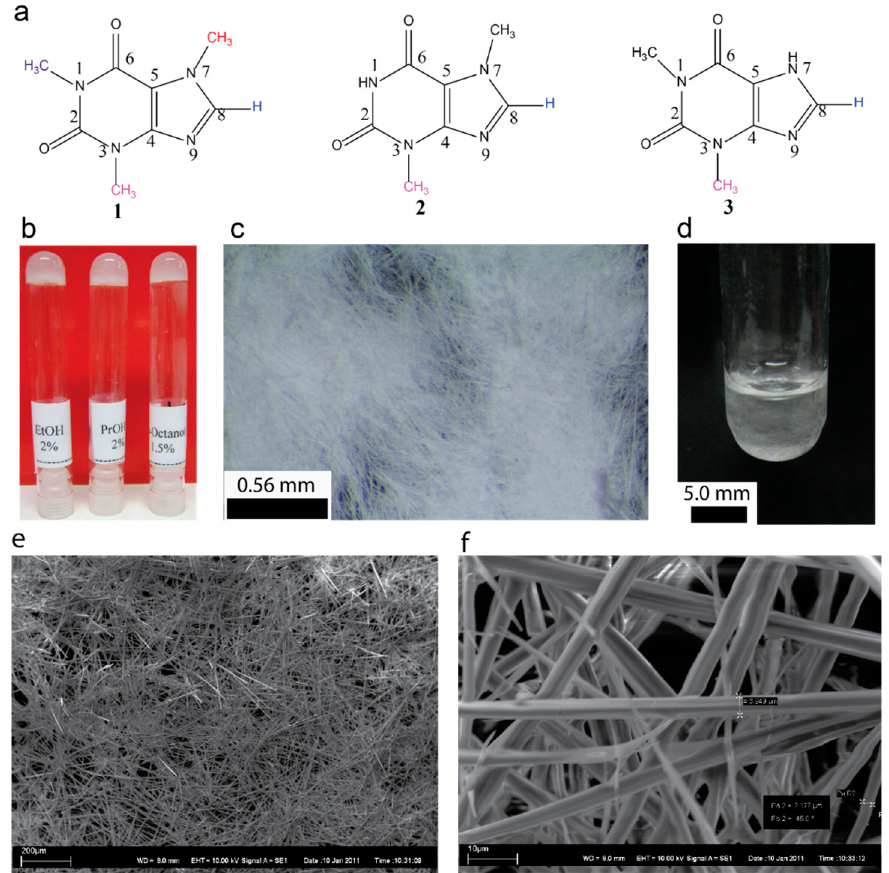
Figure 1. ( a ) Chemical structures of molecules used in this study, caffeine 1 , theobromine 2 , and theophylline 3 ; ( b ) representative photographs of gels (2.0 w/v%) derived from caffeine; ( c ) 1-propanol gel upon placing on a glass slide shows entangled microfibrillar network; ( d ) photograph of 2.0 w/v% of caffeine in 1-propanol upon cooling a hot solution shows the fiber network before forming a stable gel; ( e ) and ( f ) SEM micrographs of 1-Octanol xerogel (2.0%).